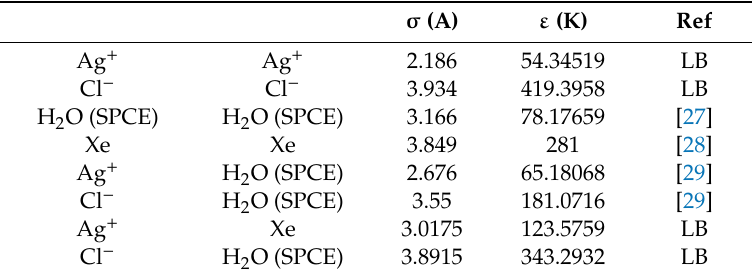
Table 3. Lennard-Jones parameters used in this work a